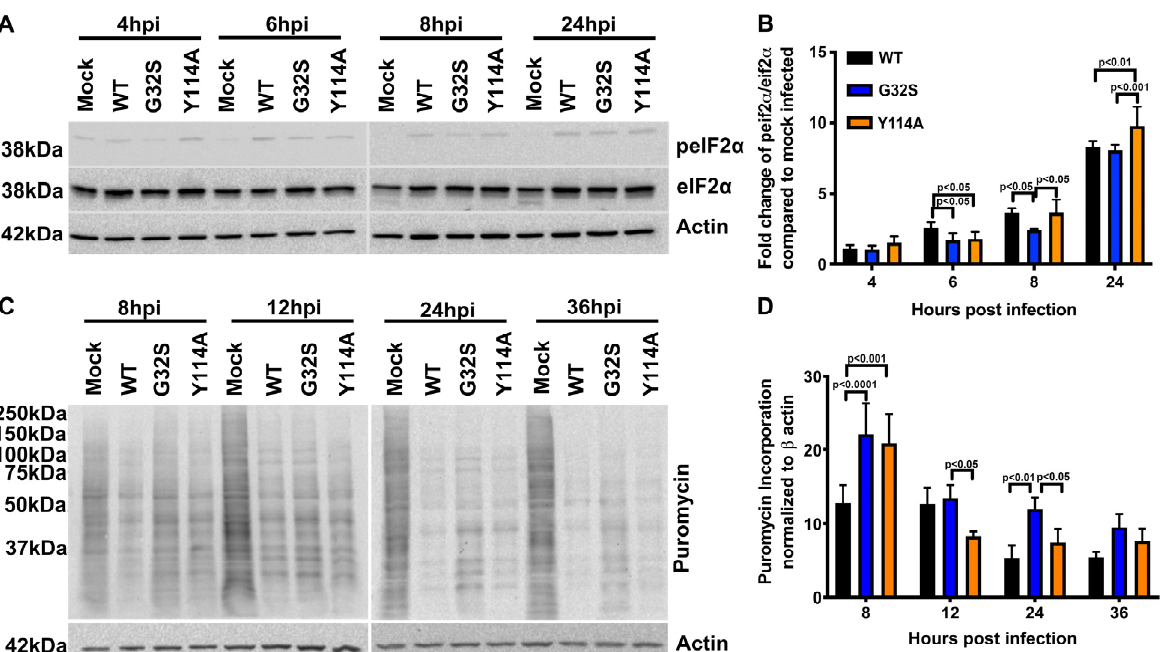
Figure 4. Effect of nsP3 MD function on host translational shut-off in CHIKV-infected astrocytes. C8-D1A cells were infected with CHIKV 181/25 (WT) or nsP3 MD mutants G32S and Y114A at an MOI of 5. ( A ) Representative immunoblots of lysates from cells 4, 6, 8, and 24 h post infection (hpi) probed for phospho-eIF2 α , total eIF2 α , and β actin. ( B ) Ratios of phospho-eIF2 α to total eIF2 α were determined by densitometry and normalized to β actin. Data from 3 experiments are plotted as the mean fold change relative to mock-infected C8-D1A cells. ( C ) Representative immunoblots of lysates from C8-D1A cells incubated at 8, 12, 24, and 36 h after infection with medium containing puromycin and probed with antibodies to puromycin and β actin. ( D ) Puromycin incorporation was normalized to β actin and data plotted as a graph. Change in puromycin incorporation is indicated as the average ± SD from three independent experiments. p values indicate the significance of differences between WT and G32S/Y114A or between G32S and Y114A at the indicated time